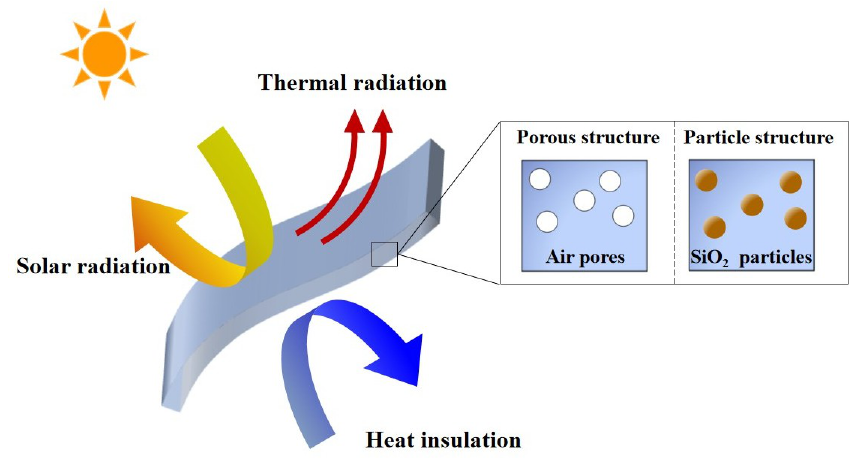
Figure 1. Diagram of radiative cooling film for different